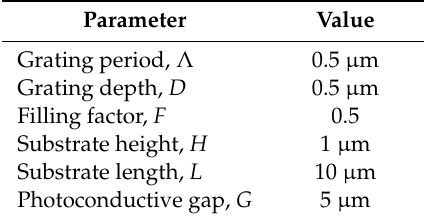
Figure 3. The schematic diagram of ( a ) the proposed periodic grating PCA and ( b ) a reduced structure for simulation purposes. Yellow color represents the photoconductive substrate, LT-GaAs, while gray color illustrates the electrodes of PCA. ( c ) The developed simulation model captured from the COMSOL Multiphysics Version 5.4 software. Table 1. The geometrical parameters of the grating PCA.